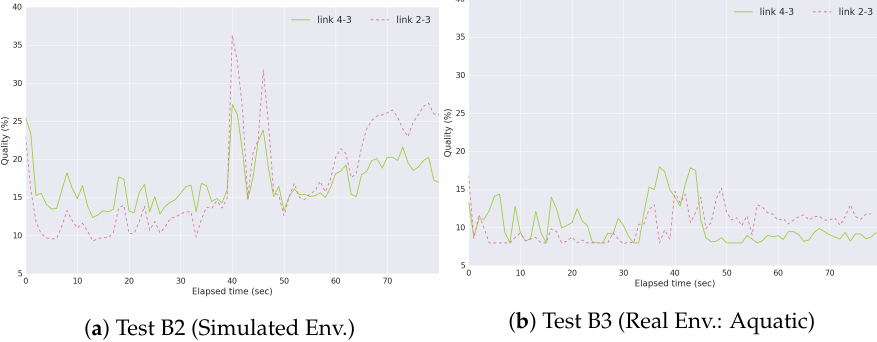
Figure 19. Quality values given by Equation (2) for link 4–3 and link 2–3 in Scenario B.